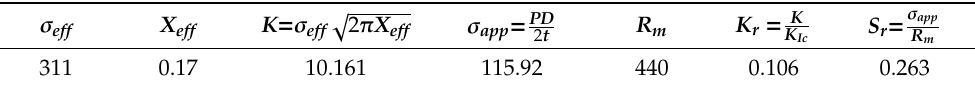
Table 2. Coordinates of the operational condition.